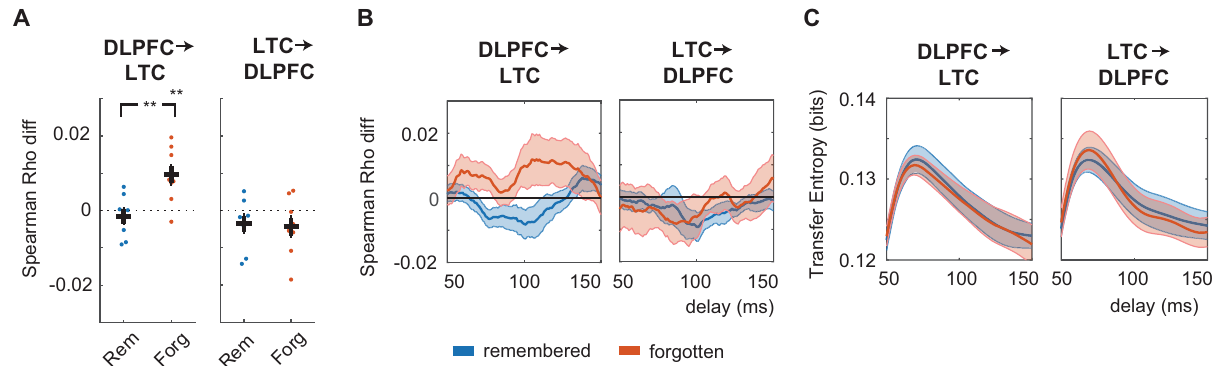
Fig. 6 Encoding-retrieval similarity of item-speci fi c patterns of top – down control. A Item-speci fi c encoding-retrieval similarity of remembered (blue) and forgotten (red) to-be-forgotten (TBF) items based on transfer entropy. Left: top – down control (dorsolateral prefrontal cortex (DLPFC) → lateral temporal cortex (LTC)), right: bottom – up connectivity (LTC → DLPFC). Double asterisks indicate signi fi cance at the 0.01 level ( n = 10; two-sided paired t test [ p = 0.005] and two-sided one-sample t test [ p = 0.004]). B Item-speci fi c encoding-retrieval similarity of top – down control patterns for various interregional delays. Shaded error bars indicate the standard error of the mean. C Overall transfer entropy values during retrieval. Error bars indicate the standard error of the mean. Source data are provided as a Source Data fi effect of instruction (6 – 30 Hz; 0.35 – 0.85 sec; p = 0.013; max t (16) hemisphere showed a trend for stronger ERS than the right value = 4.636; Fig. 7A) with a cluster showing relatively higher hemisphere (Supplementary Fig. 11; independent t test: alpha/beta power after a TBF cue compared with a TBR cue (less t (23) = 1.98, p = 0.059). Restricting the analyses to only the pronounced reductions as compared with baseline, i.e., reduced participants with both left and right electrodes did indicate a desynchronization) as well as an interaction effect (2 – 11 Hz; signi fi cant hemisphere effect (paired t test: t (8) = 4.79, p = 0.001).